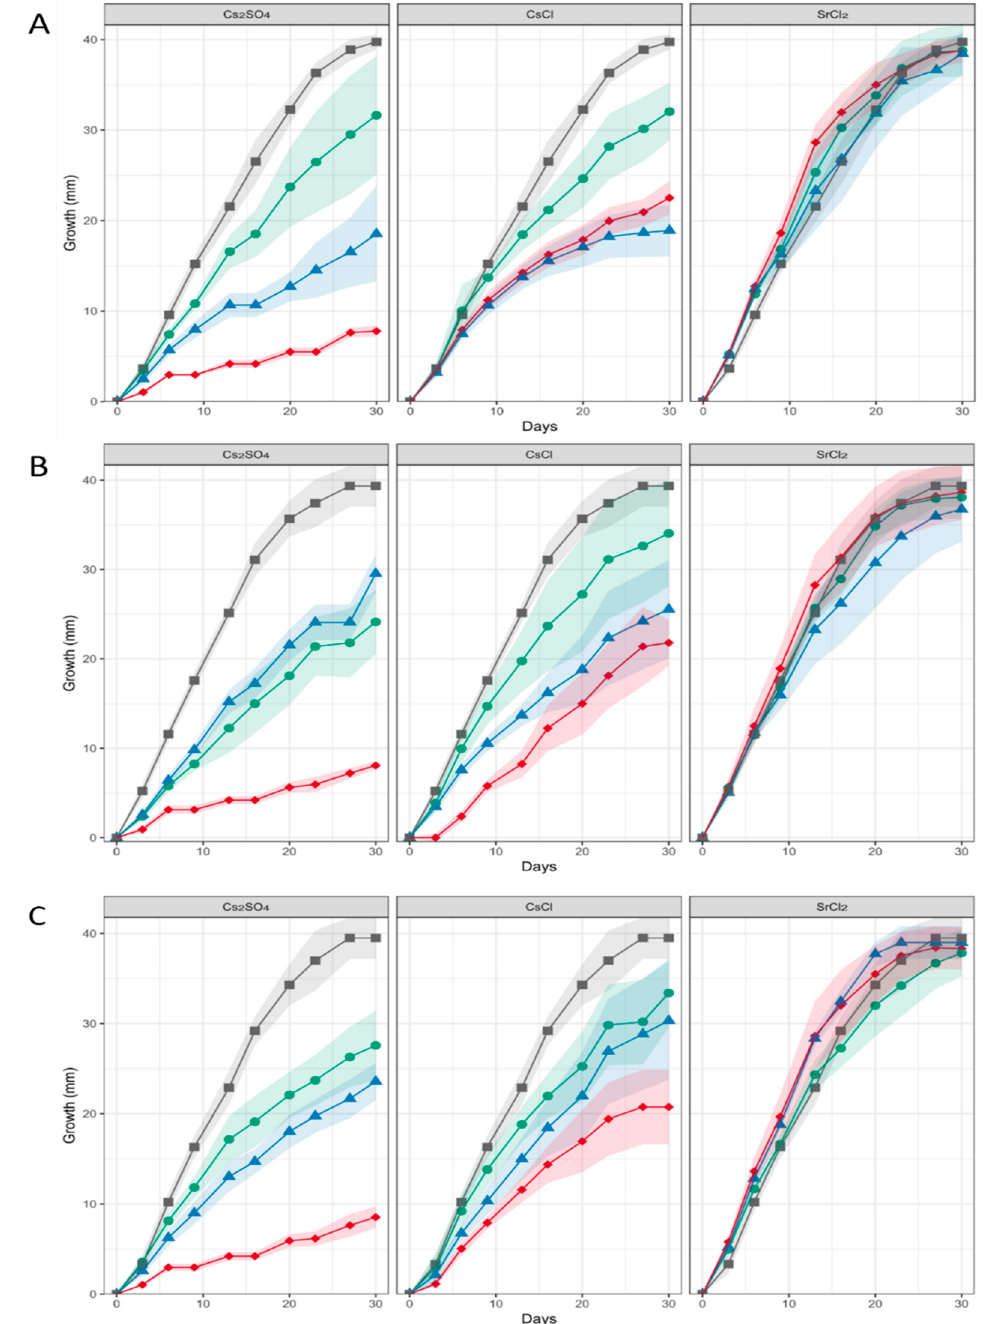
Figure 3. Growth of Aspergillus sp. SFB31 ( A ), SFB32 ( B ), and SFB84 ( C ) on Sr and Cs containing media. The respective metal salt (indicated on top of each graph) were applied at 0 mM (black curves), 25 mM (green), 50 mM (blue) and 100 mM (red). The shaded area denotes standard deviations in growth radius scored for each colony obtained from standardized inocula.